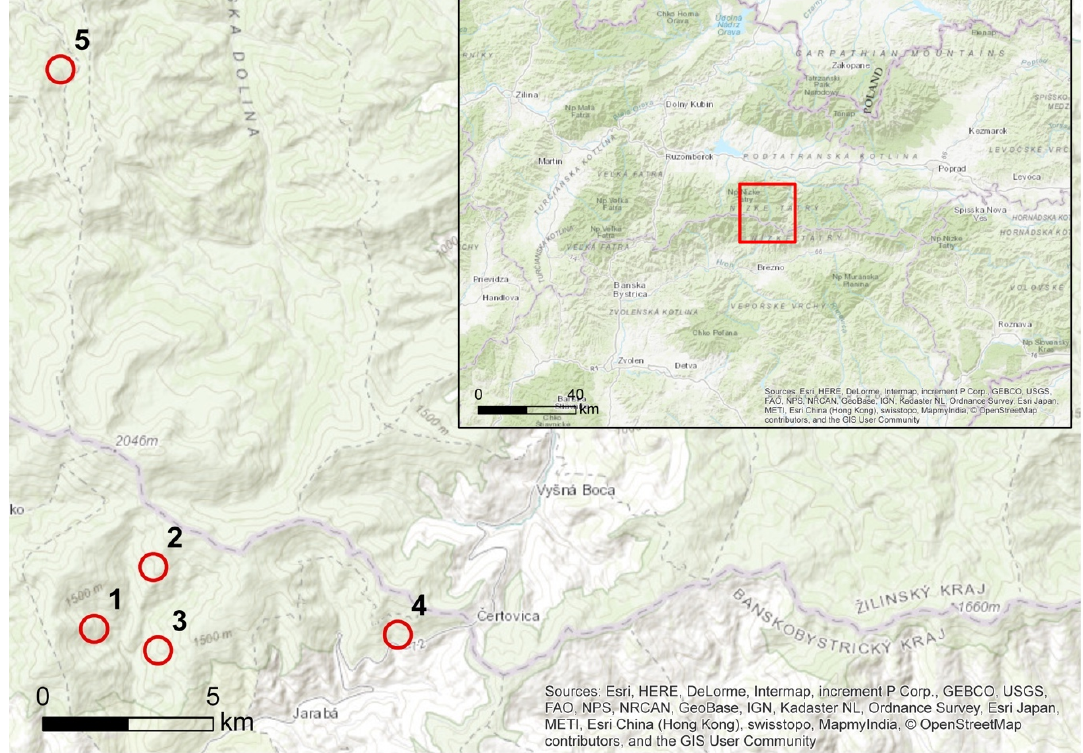
Figure 2. Map of the used localities in the Low Tatras (Source: Own work/ESRI ArcMap Basemap). The number of the points represents the ID numbers.